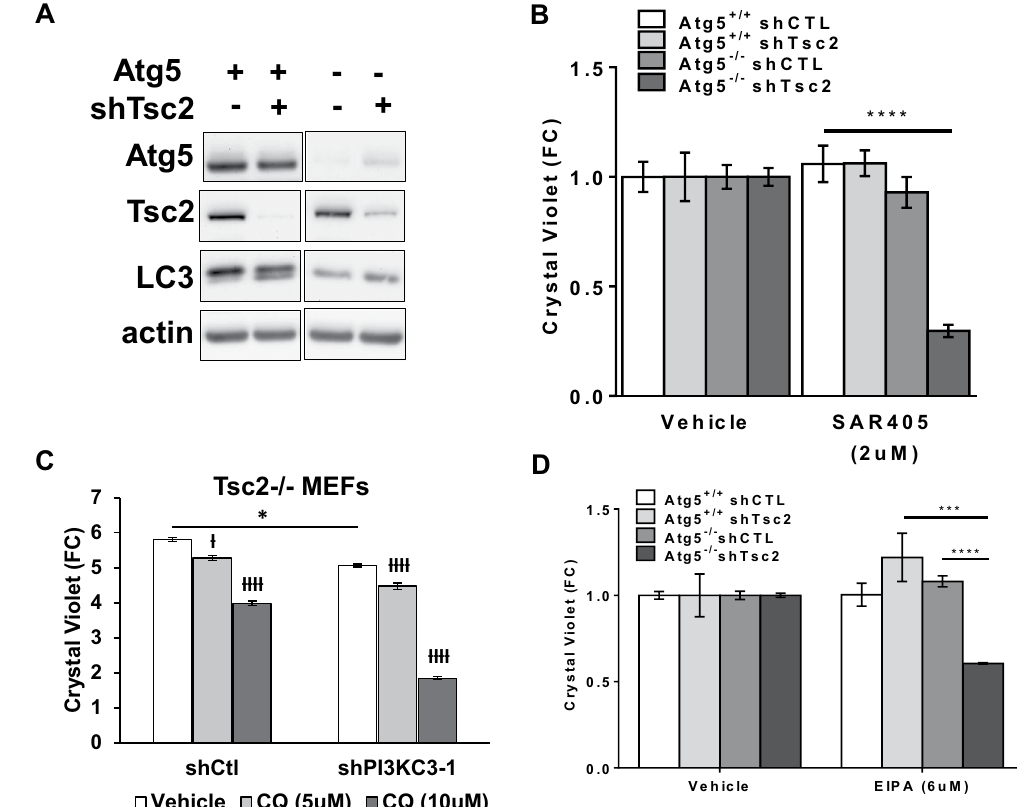
Figure 4. Autophagy inhibition synergizes with Vps34 inhibition or macropinocytosis inhibition to selectively inhibit proliferation of Tsc2-deficient cells. ( A ) Immunoblots confirmed Tsc2 downregulation in Atg5 + / + and Atg5 − / − MEFs. The blot was cropped to highlight the relevant bands. The full-length blot is presented in Supplementary Figure 5A. ( B ) Proliferation of Atg5 − / − shTsc2 MEFs grown in 1% FBS DMEM was selectively inhibited by Vps34 inhibitor SAR405 (2 uM, 48 hours). ( C ) Vps34 downregulation sensitized Tsc2 − / − MEFs to CQ treatment (5 uM, 72 hours). ( D ) Proliferation of Atg5 − / − shTsc2 MEFs grown in 1% FBS DMEM was selectively inhibited by the macropinocytosis inhibitor EIPA (6 uM, 48 hours). Data represented as mean + / − standard deviation of six biological replicates. Statistical significance was assessed using two-way and one-way ANOVAs with Bonferroni correction with * p < 0.05, *** p < 0.001, **** p < 0.0001. ƚ p < 0.05, ƚƚƚƚ p < 0.0001 when comparing treated to vehicle treatment in same cell